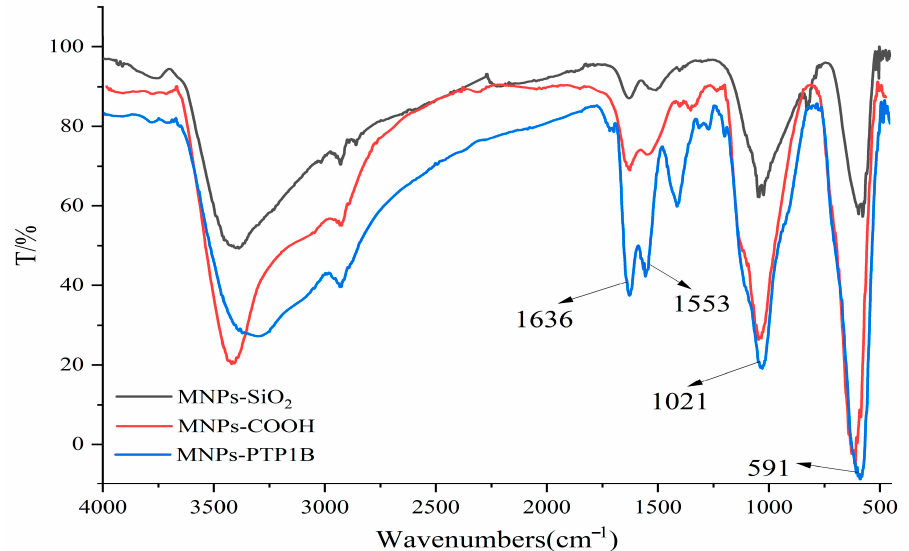
Figure 2. FT − IR spectra of MNPs − SiO 2 , MNPs − COOH, and MNPs − PTP1B.